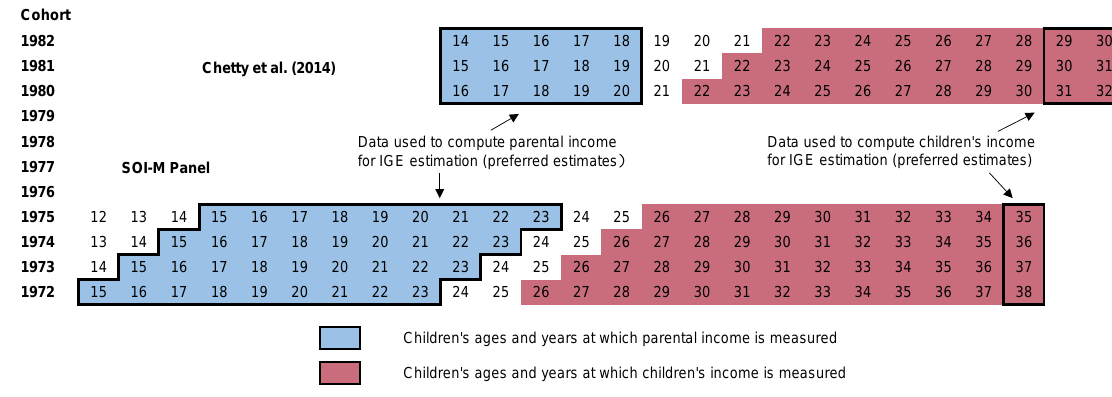
Children's ages and years at which parental income is measured Children's ages and years at which children's income is measured